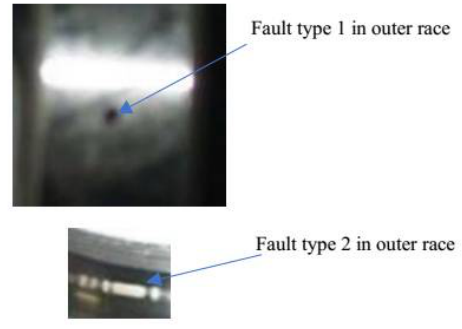
Figure 5. Fault types simulated in the bearing.